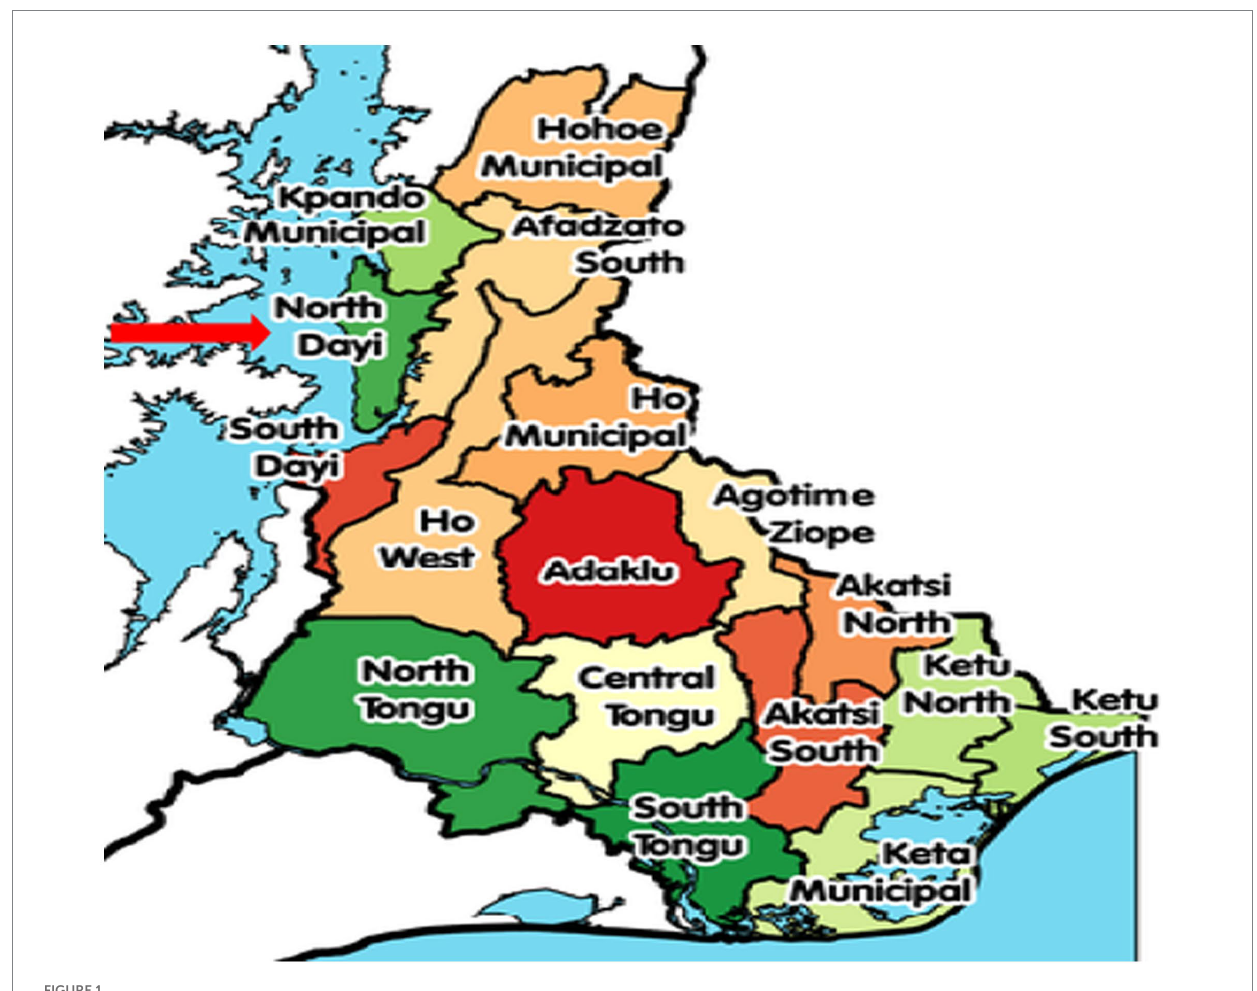
FIGURE 1 Map showing the North Dayi district where the study was conducted in the Volta Region,